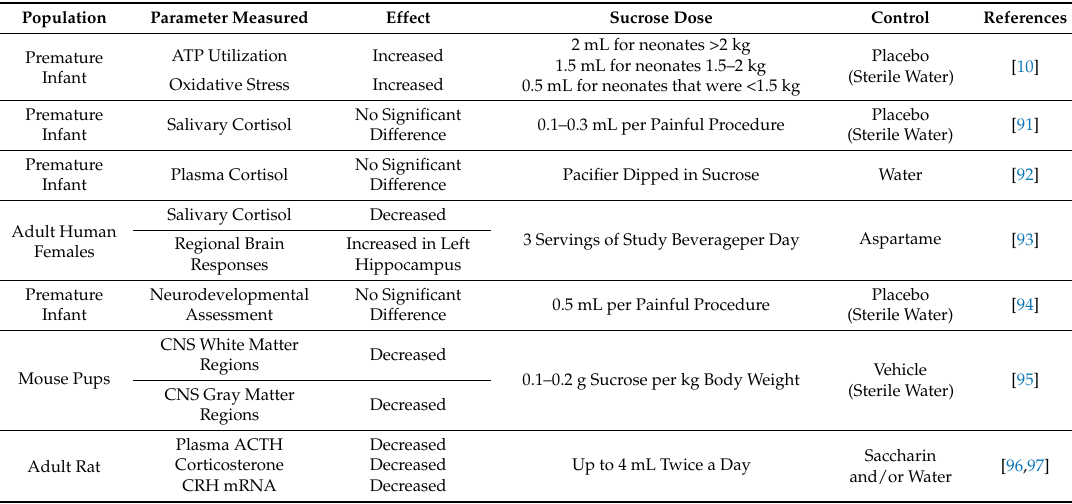
Table 1. Summary table of studies that examined other variables besides pain response